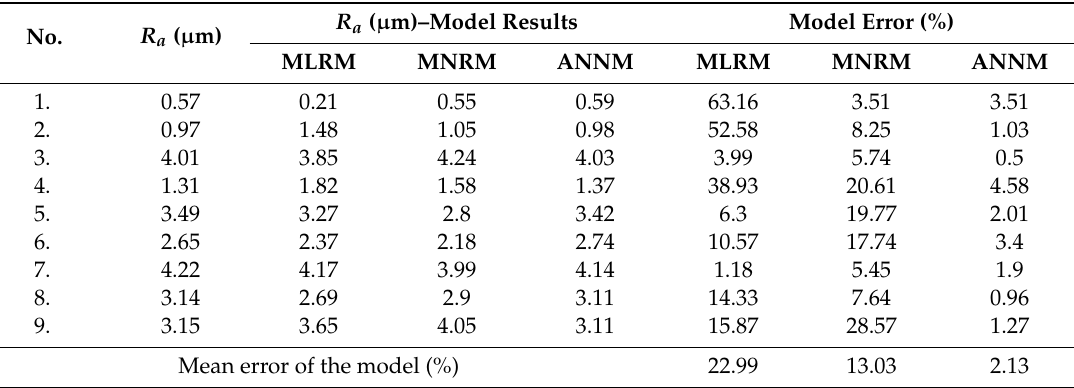
Table 16. The comparative analysis of experimental results and models with torque for TD drilling with CB in test tubes hardness 28 HRC.